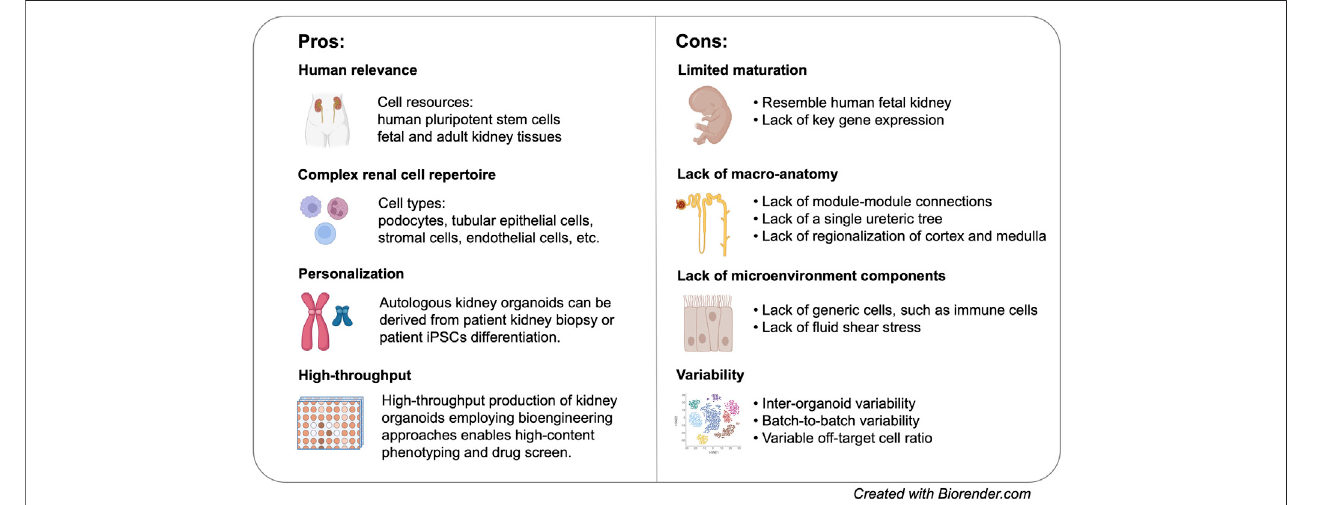
FIGURE 2 | Pros and cons of kideny organoid models for disease